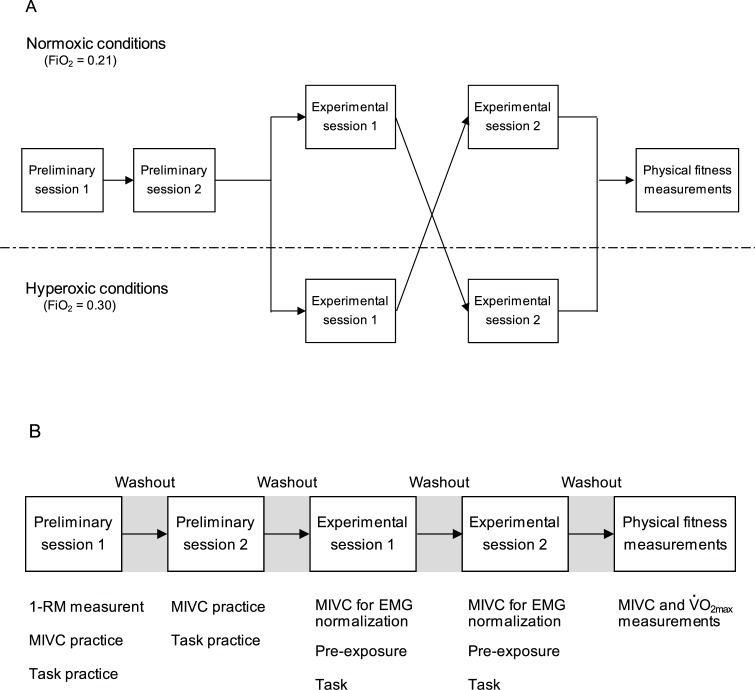
Experimental design.